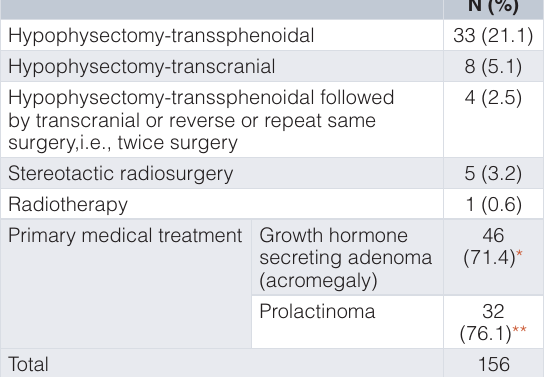
Table 4. Type of treatment for pituitary adenoma.